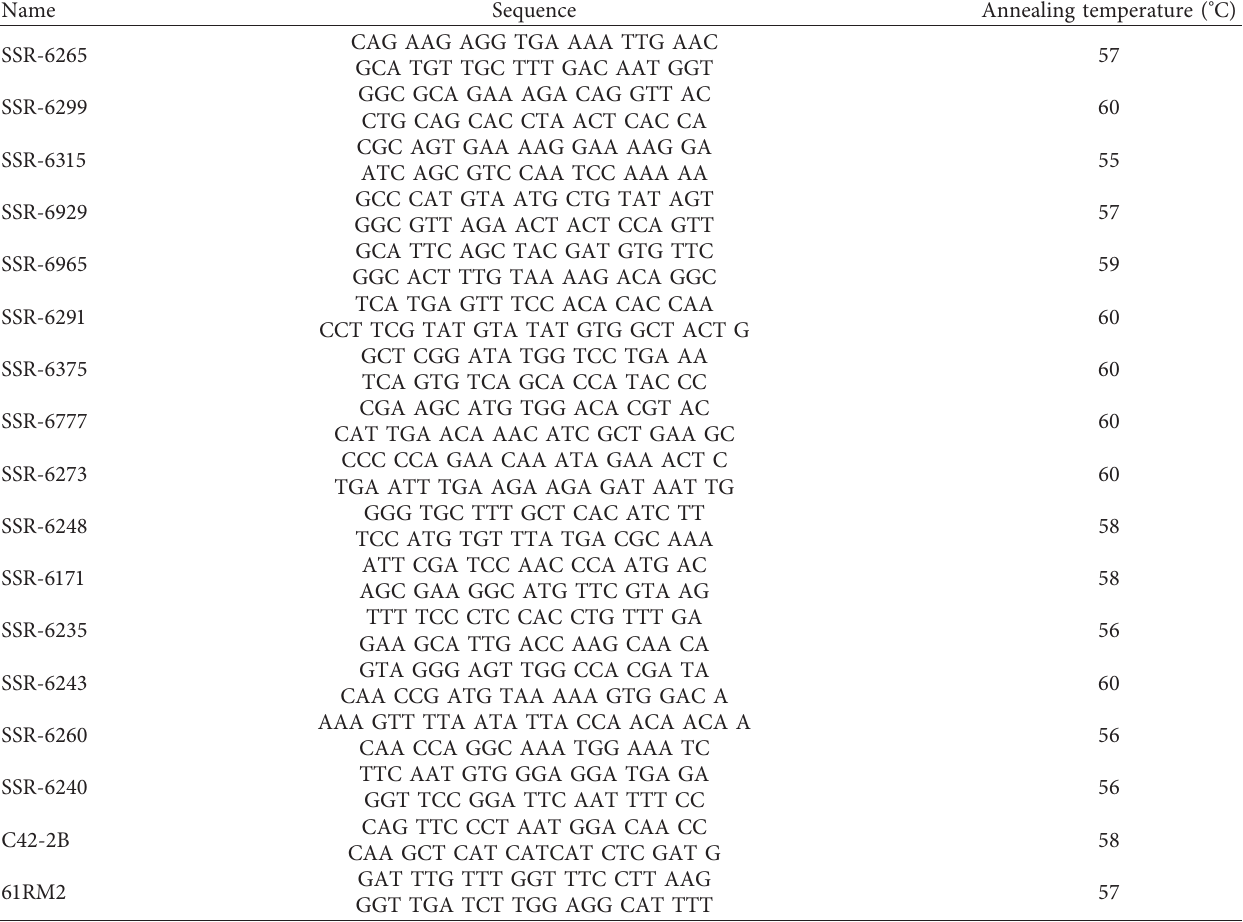
Table 1: SSR primers used, their sequences, and annealing